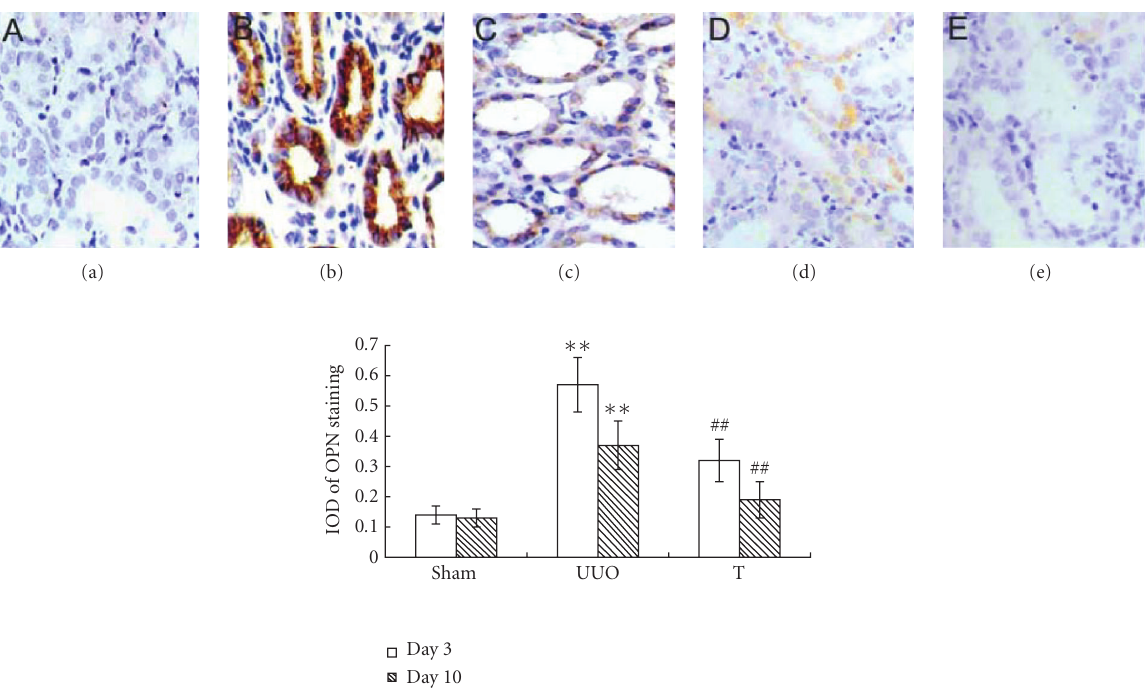
Figure 4: Staining of OPN at di ff erent time points in di ff erent groups ( × 200) . Using antibody against OPN, sections were stained by immuno- histochemistry. Labeling index was expressed by integral optical density (IOD): (a) sham group, (b) UUO on day 3, (c) UUO on day 10, (d) treatment group on day 3, and (e) treatment group on day 10. ∗∗ : P < . 01 versus sham group of the same time point. ##: P < . 01 versus UUO group of the same time